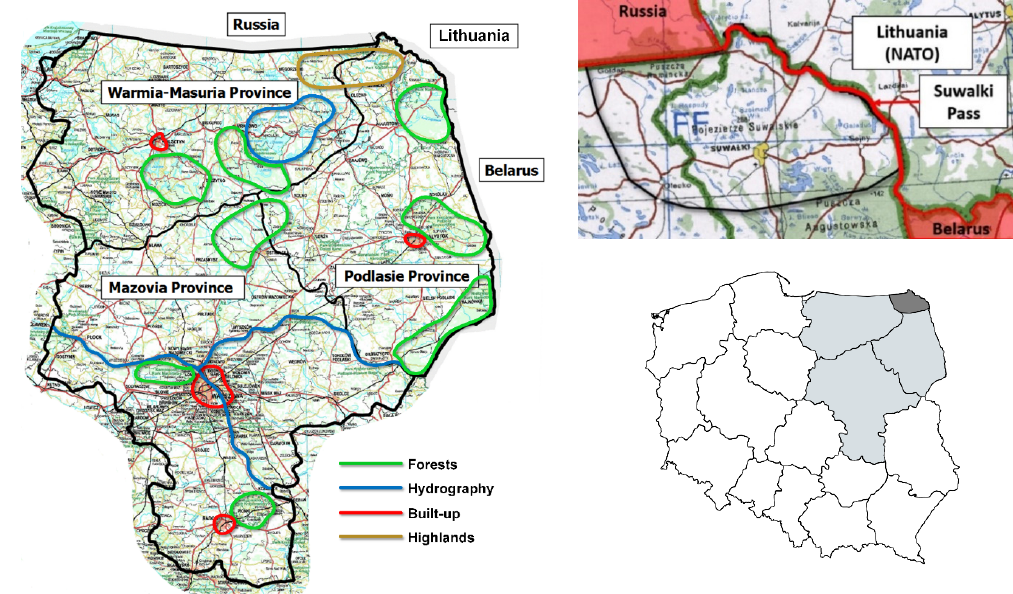
Figure 2. Test areas ( left side—cell shape analysis, right side—cell size analysis). NATO—North Atlantic Treaty Organization.